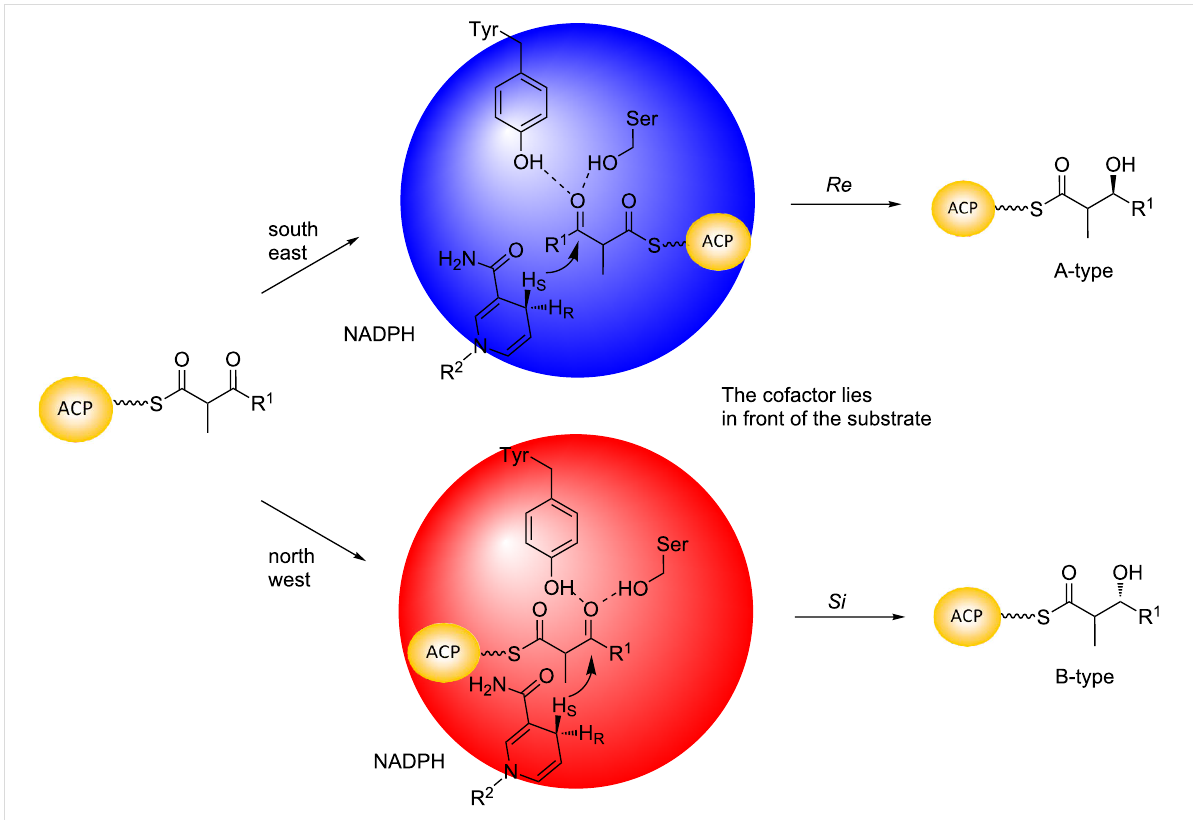
Figure 11: Models for control of the stereochemistry of reduction by KR domains. The two directions of ketoreduction achieved by a conserved cata- lytic apparatus (i.e. positions of the catalytic tetrad and NADPH cofactor) are obtained by entry of the ACP-bound substrate from one or the other side of the active site [68]. ‘South east’ entry gives reduction on the re face and an ‘A-type’ product, while the alternative ‘north-west’ entry yields si face reduction, and a ‘B-type’ hydroxy